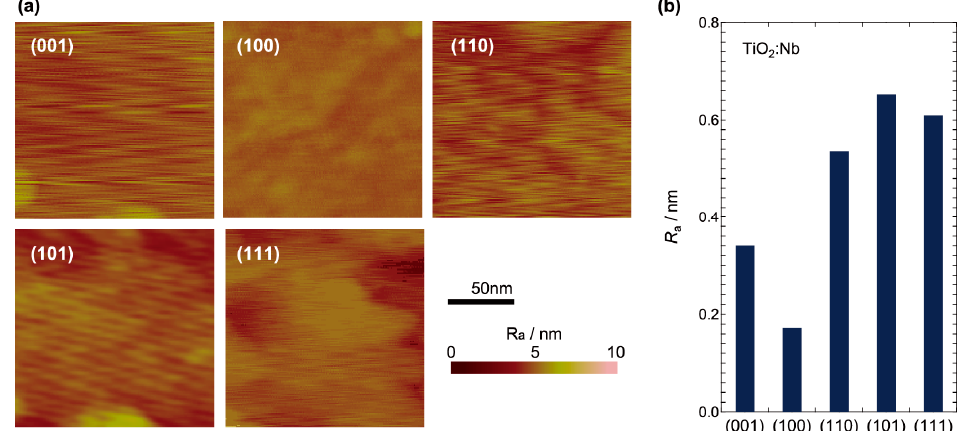
Figure 2. ( a ) AFM images and ( b ) surface roughness ( R a ) values for the TiO 2 :Nb single-crystal substrates.